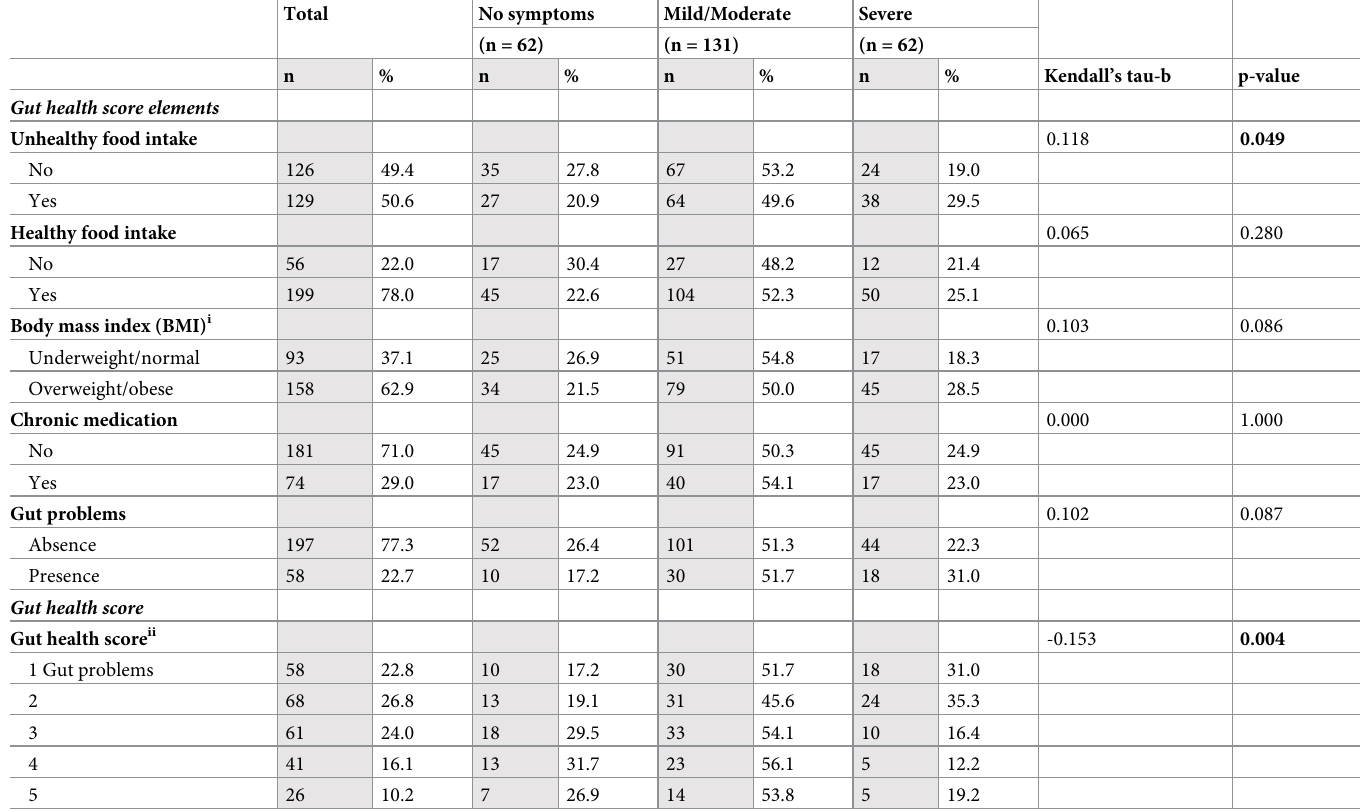
Table 3. Description of gut health core elements and gut health score and their association with COVID-19